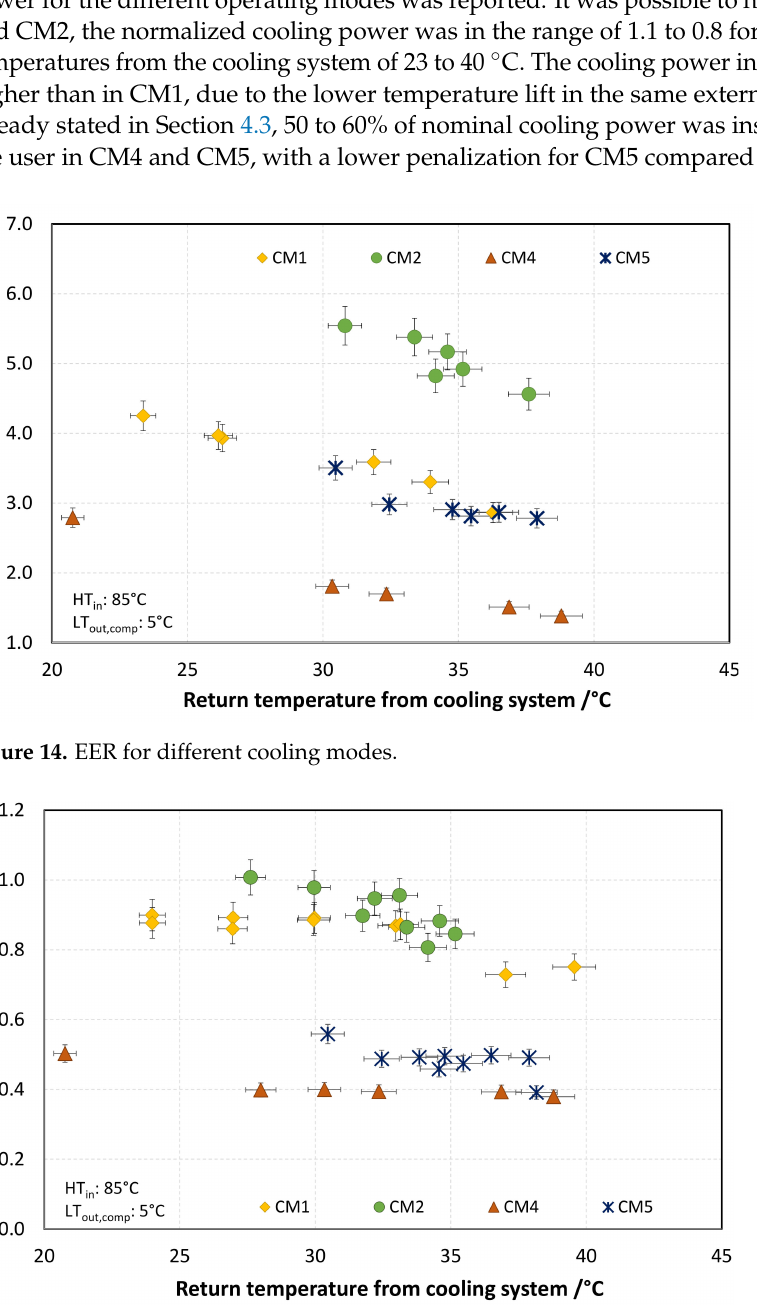
Figure 15. Normalized cooling power for different cooling